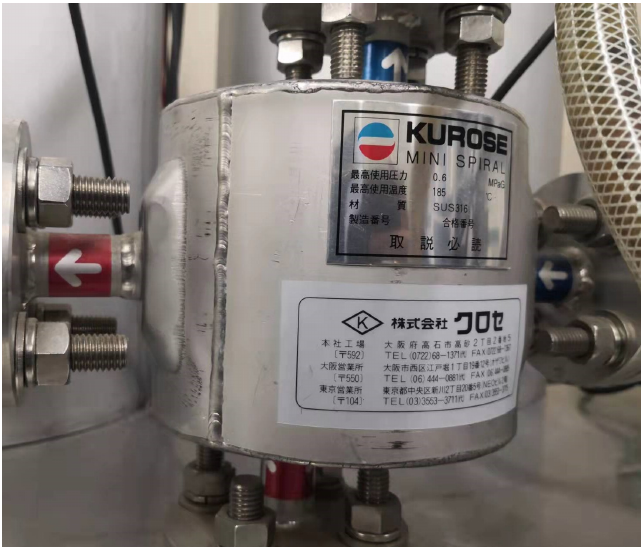
Figure A1. A spiral heat exchanger plant. Mini Spiral is a super compact spiral heat exchanger from Kurose Chemical Equipment Co., Ltd. in Japan. Design pressure is 0.6 MPaG. Design temperature is 185 ◦ C. Material (JIS) is SUS316.